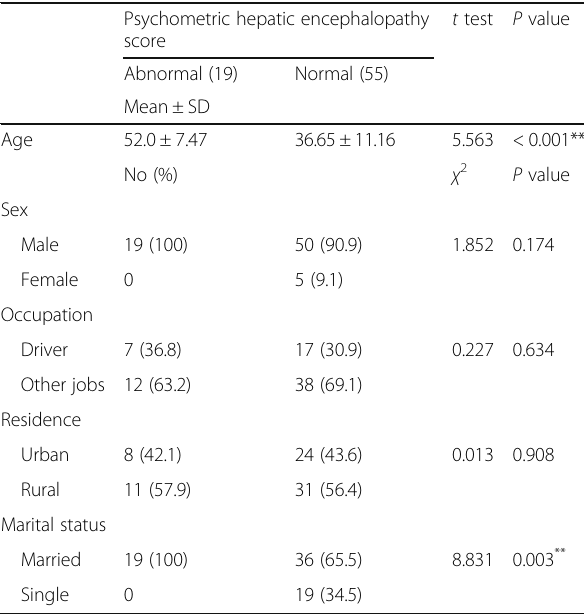
Table 1 Psychometric hepatic encephalopathy score and descriptive